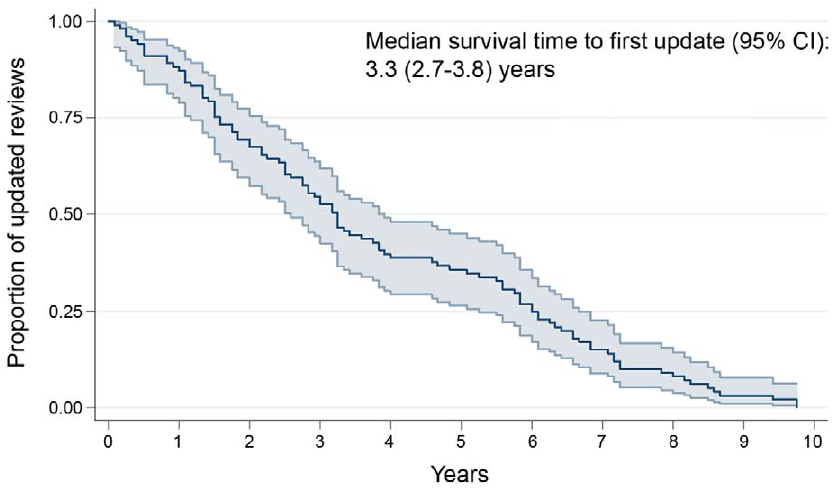
Figure 2. Kaplan–Meier curves with 95% confidence interval for sample of 101 reviews at first update.